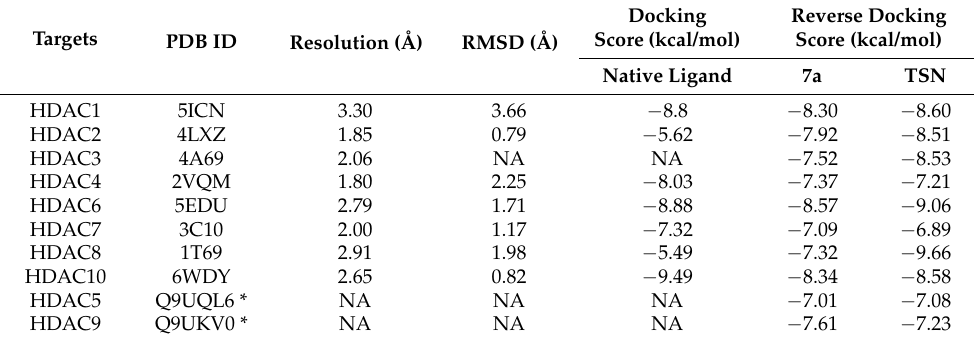
Figure 6. Superimposition of the co-crystallized poses (yellow) and the docking pose (green) of the same ligands. ( a ) (HDAC1), ( b ) (HDAC2), ( c ) (HDAC4), ( d ) (HDAC6), ( e ) (HDAC7), ( f ) (HDAC8), ( g ) (HDAC10). Table 5. Reverse Docking results of studied compounds with HDAC isoforms (1–10), along with their PDB codes, resolution and self-docking RMSD